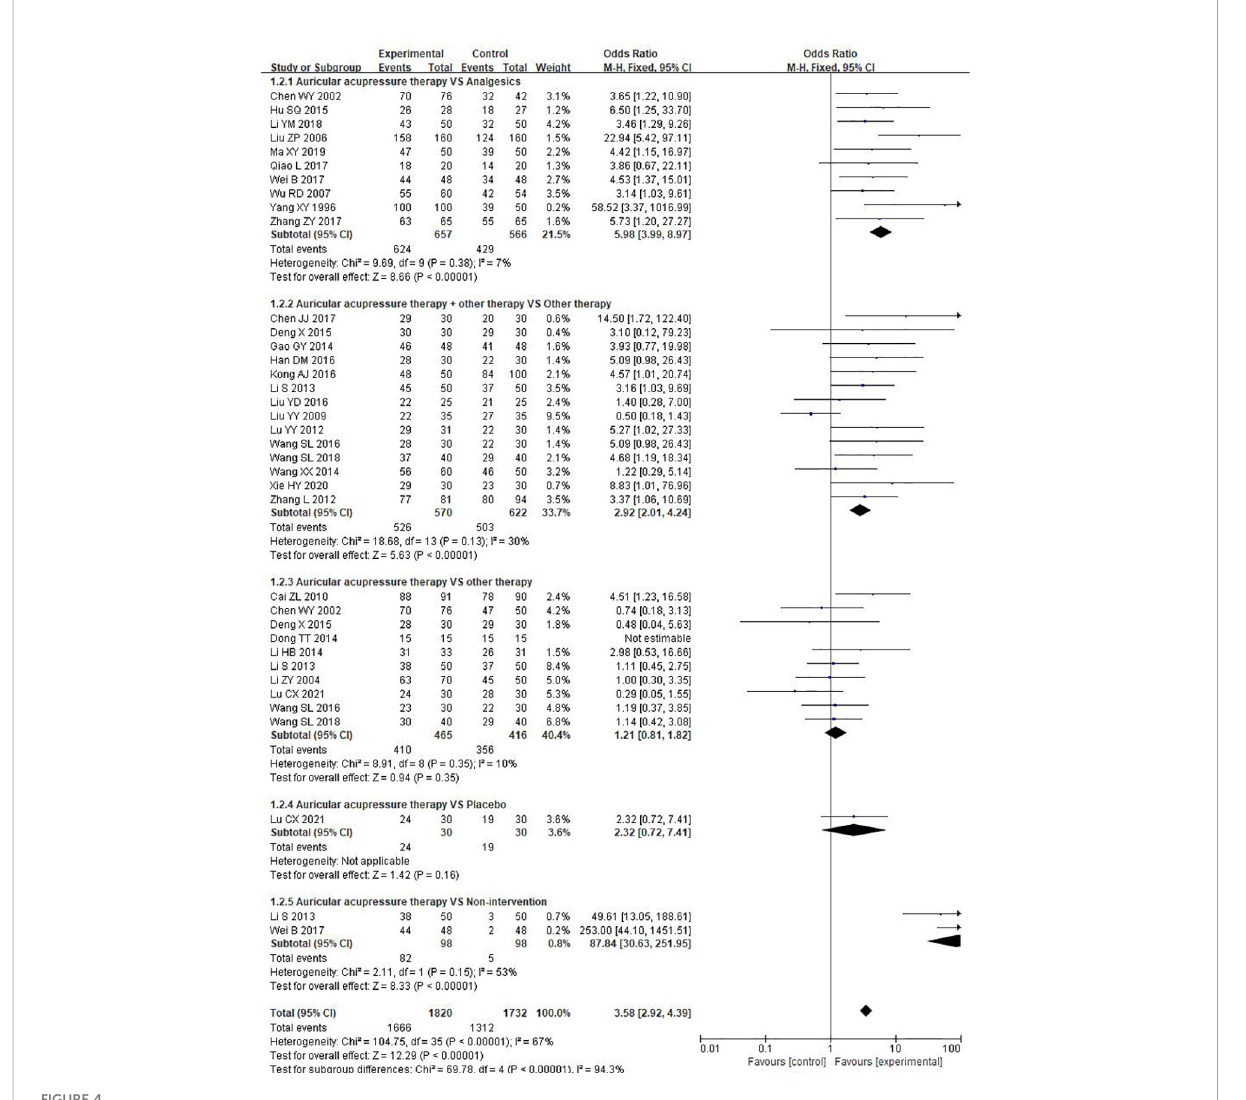
FIGURE 4 Meta-analysis and forest plot for total effective